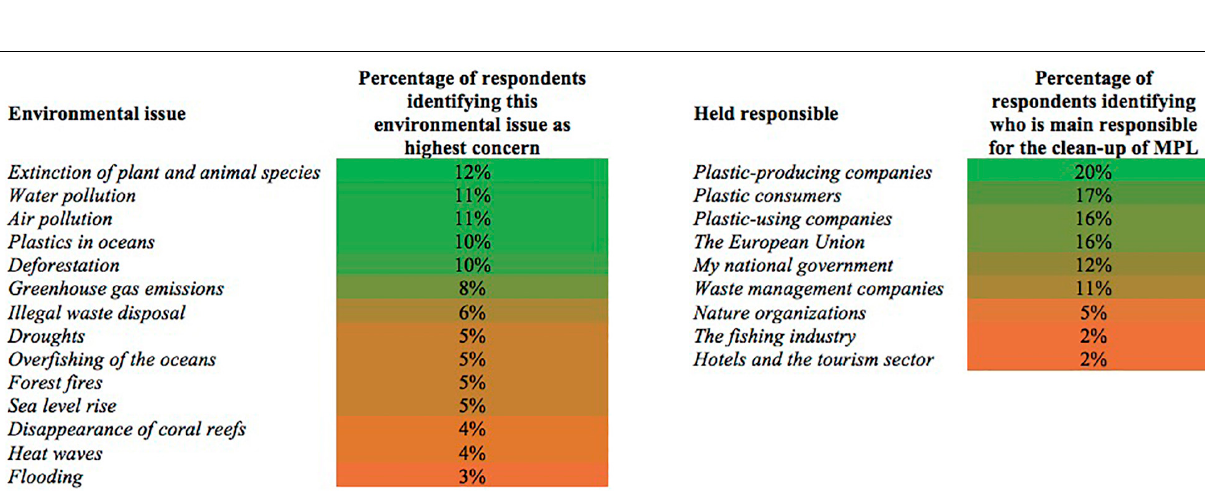
FIGURE 4 | Distribution of public concern about plastic pollution in seas and oceans. Responses to the statement “ I’m very worried about plastic pollution in seas and oceans .”